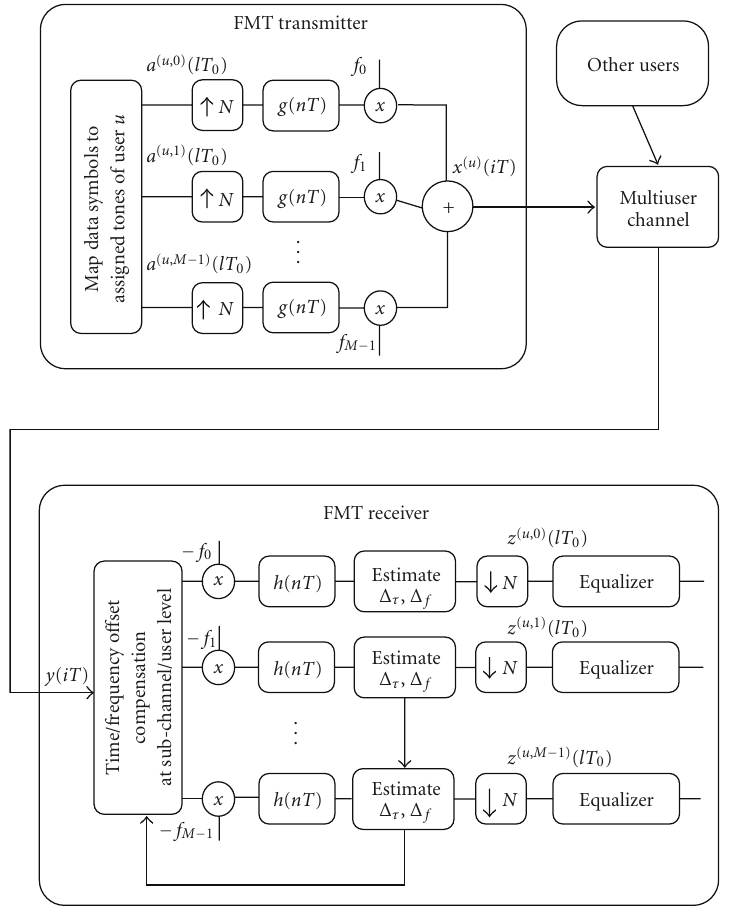
Figure 1: Multiuser FMT system model with transmitter and receiver of user u